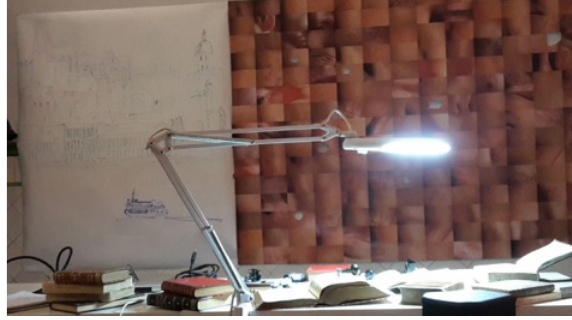
Figure 3 | Emerging Self Performance Festival FACTT Lisbon MATT. Source: the author, 2017 The performance presents a play between the characteristics of the skin (viscosity, color, elasticity, shape, density, etc.) and an attentive look at the mutation of the surface (skin of self-body), all mediated in a sequence of actions ranging from stamping (digitizing) digits into memory / archive surfaces (old books about nature, body, skin, and memory). Several designs are built in space that are wrapped with paper and space support. The actions that constitute the performance, such as, dissecting,